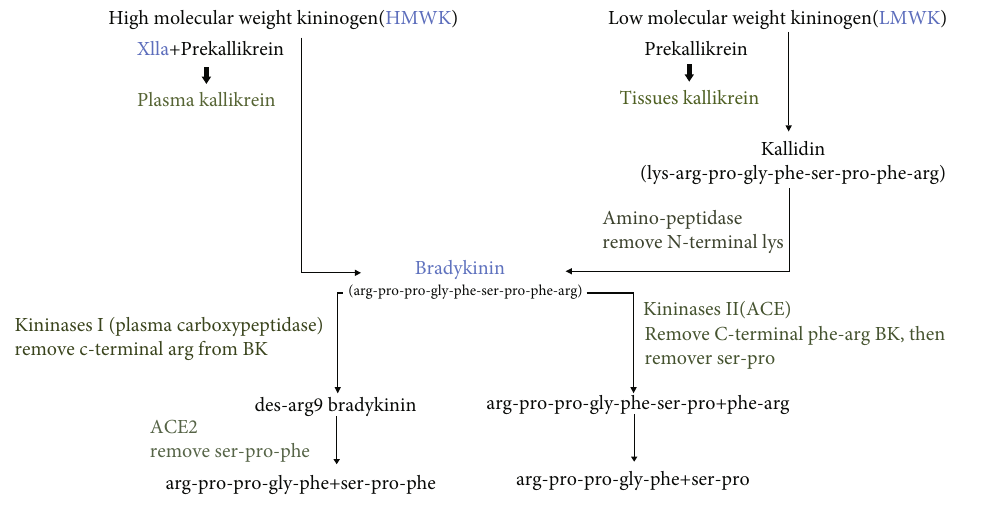
Figure 1: Bradykinin synthesis and